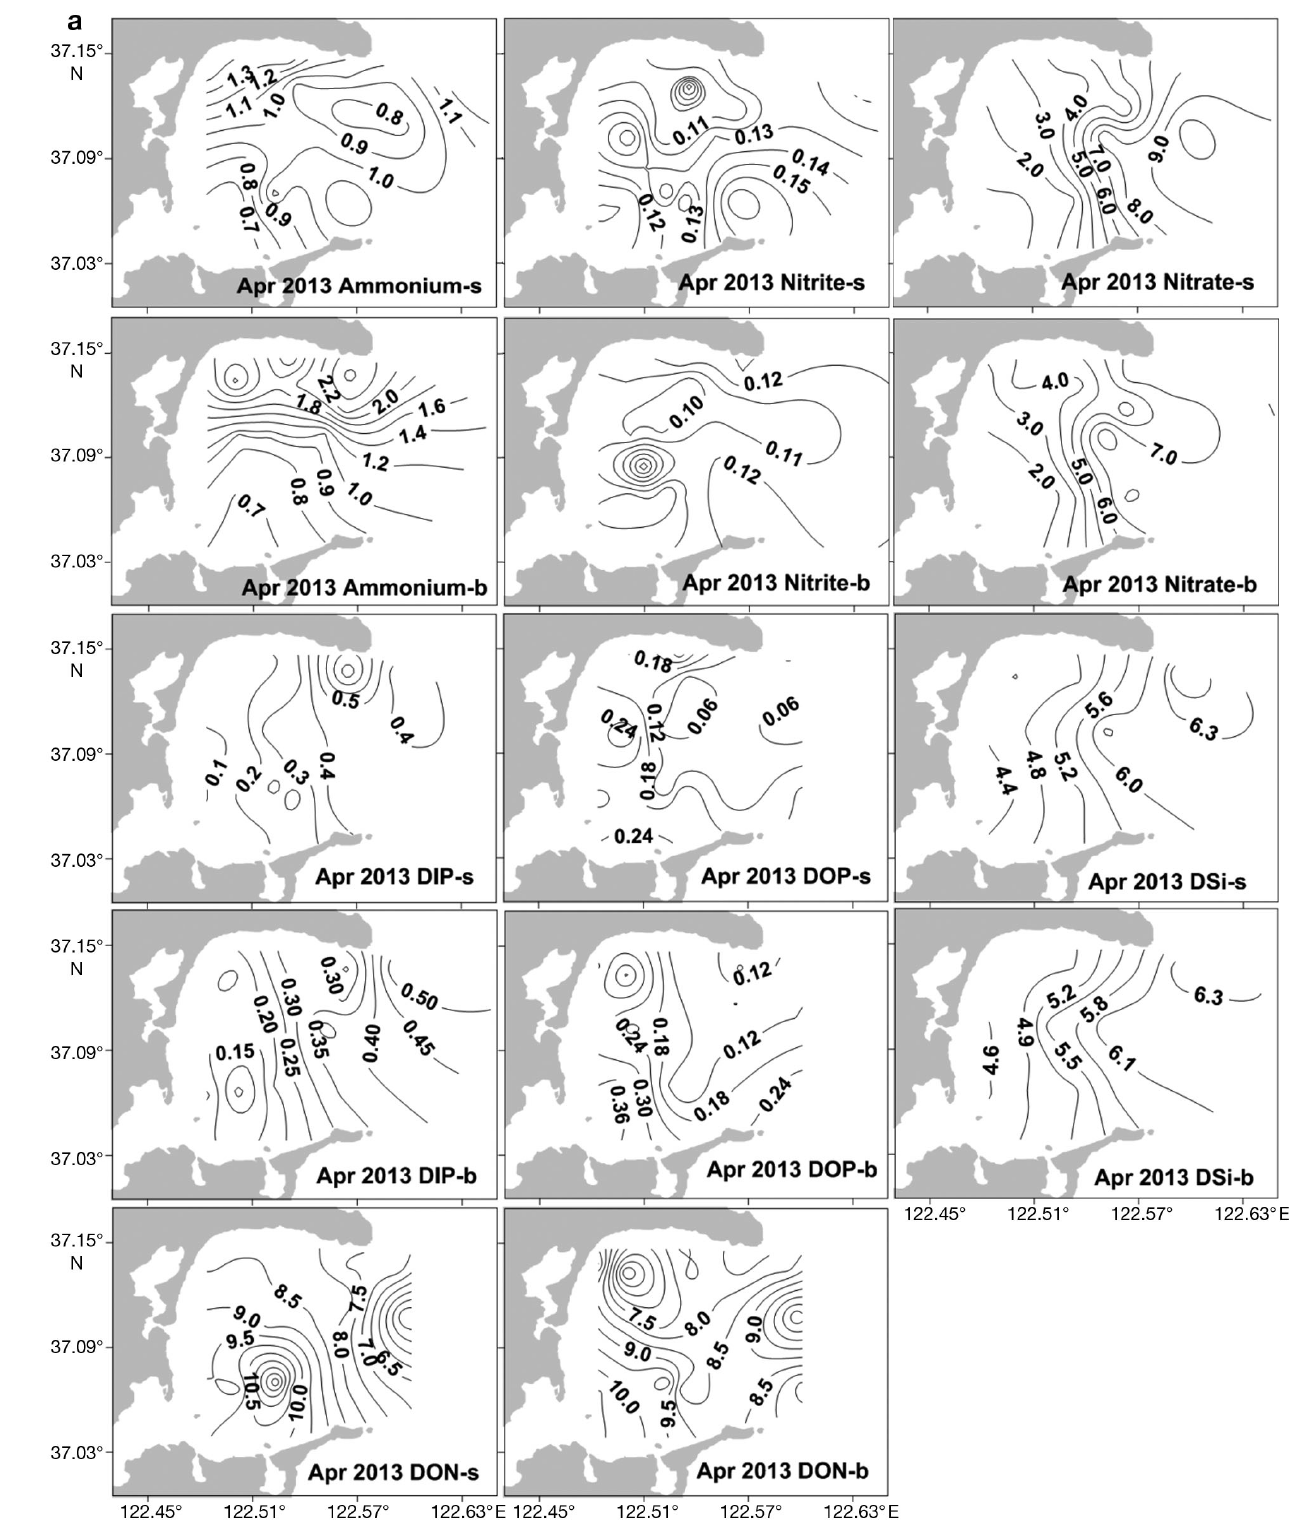
Fig. 4. Horizontal distributions of nutrients (µM) in Sanggou Bay: (a) April 2013; (b) June 2012; (c) July 2013; (d) October 2012; (e) October 2013; (f) January 2014. DIP (DOP): dissolved inorganic (organic) phosphorus, DSi: dissolved silicate, DON: dissolved organic nitrogen. s: surface; b: